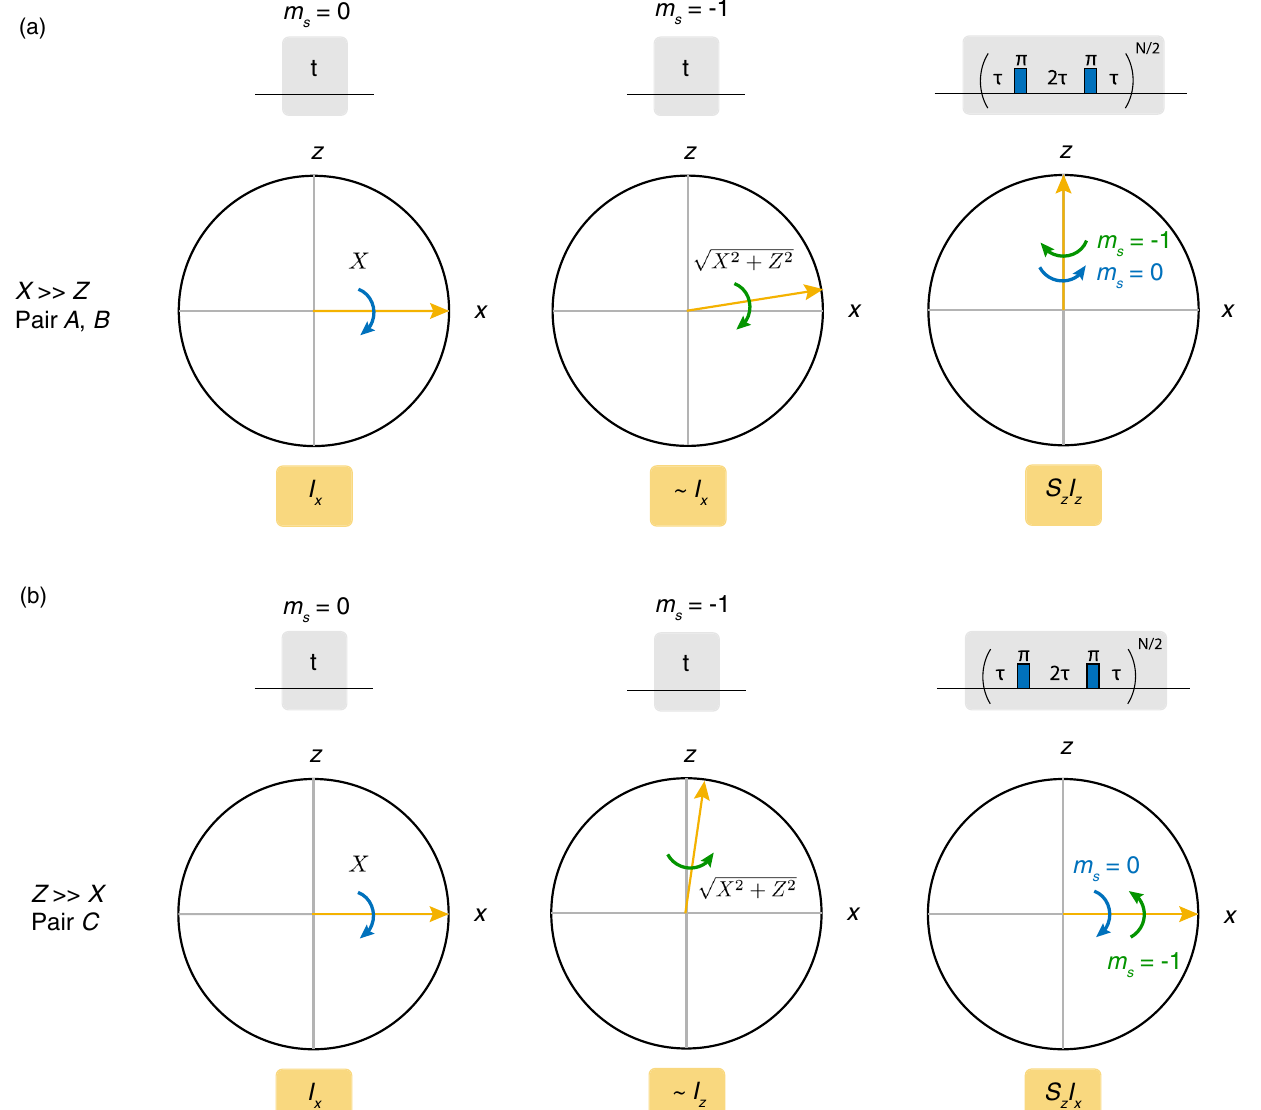
FIG. 5. Overview of pair pseudospin dynamics during various sequences on the NV electron spin. (a) Pseudospin dynamics of pairs with X ≫ Z (pairs A and B ). The top row indicates the sequence performed on the NV electron spin, the middle row indicates the corresponding pair dynamics in the XZ plane of the pseudospin Bloch sphere, and the bottom row indicates the effective pseudospin Hamiltonian term under that sequence. For the left two columns, the rotation frequencies are given inside the Bloch spheres. From left to right, the sequences are free evolution in m s ¼ 0 and m s ¼ − 1 and a dynamical decoupling sequence with τ resonant, i.e., ffiffiffiffiffiffiffiffiffiffiffiffiffiffiffiffiffiffiffiffiffiffiffiffiffi p 2 τ ¼ π = X 2 þ ð Z= 2 Þ 2 . Rotations that are unconditional on the NVelectron spin state can be obtained by setting τ ¼ π = (unconditional z rotation) and by setting τ far off resonant (unconditional x rotation), but these are not shown or used here. Note that the z -rotation frequency depends on the hyperfine field difference Z , so that pairs A and B can, in principle, be controlled individually. (b) Pseudospin dynamics of pairs with Z ≫ X (pair C ). Like above, z and x rotations that are unconditional on the NVelectron-spin state can be obtained by setting different values for τ (not shown). Together, these operations enable universal control of the system consisting of the three pseudospins and the NV